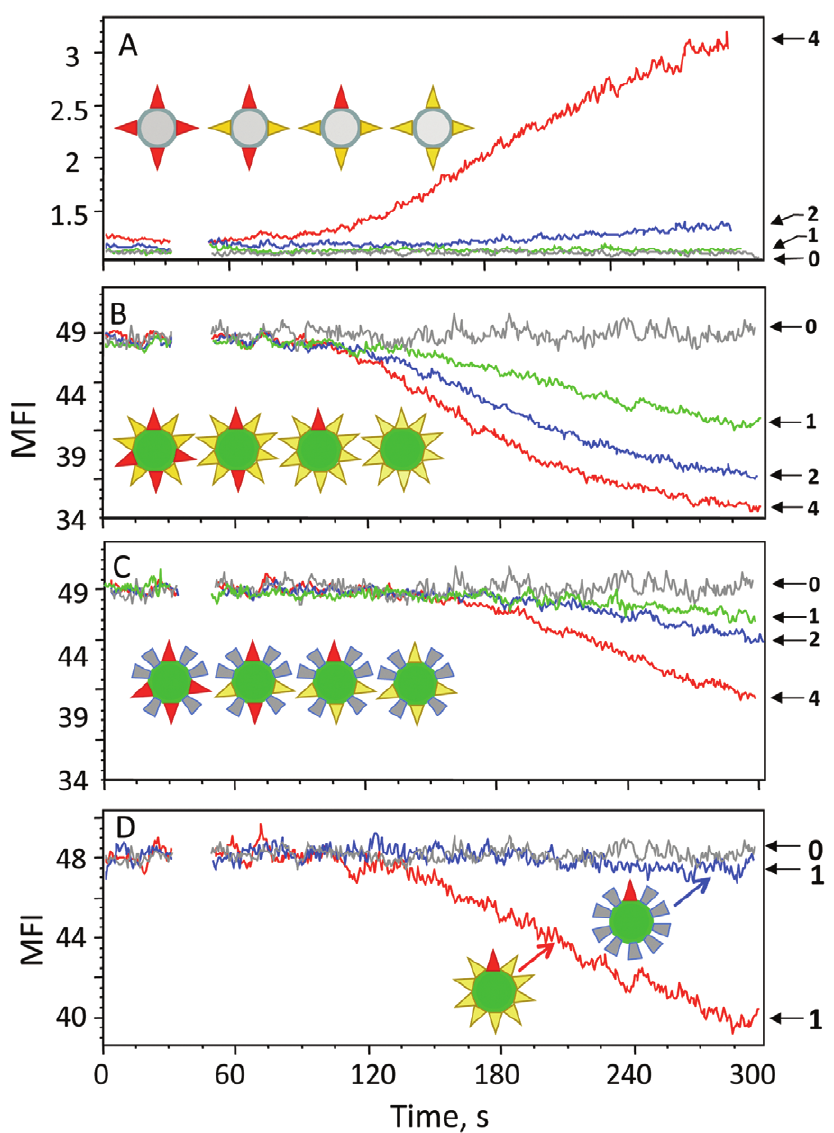
Figure 6. Kinetics of Ca 2 + flux in CTL stimulated with pMHC/QD or pMHC/Streptavidin containing cognate and noncognate or inactive pMHC ligands at various ratios. A. Time-dependent Ca 2 + accumulation in the cytoplasm of Fluo-3-labeled 68A62 CTL induced by Streptavidin-based oligomers presenting IV9-HLA-A2 (cognate, red) and Tax-HLA-A2 (noncognate, yellow) ligands at various ratios, i.e., 4:0, 2:2, 1:3, 0:4, respectively. Corresponding Ca 2 + flux traces are designated as 4 (4:0, red), 2 (2:2, blue), 1(1:3, green), 0(0:4, grey). B, C, D. Time-dependent Ca 2 + accumulation in the cytoplasm of Fura Red-labeled 68A62 CTL induced by QD-based oligomers presenting IV9-HLA-A2 (cognate, red), Tax-HLA-A2 (noncognate, yellow) or Tax-HLA-A2 mut (inactive, grey) ligands at various ratios. One series of pHLA-A2/QD conjugates being tested displayed 4, 2, 1 or 0 cognate (red) ligands per dot and 6, 8, 9 or 10 noncognate (yellow) ligands per dot keeping the total number of pHLA-A2 molecules per dot to be 10 (B). In another series of tested pHLA-A2/QD conjugates, the number of the cognate (red) ligands was the same, i.e., 4, 2, 1 or 0 per dot and the number of the noncognate (yellow) ligands per dot was 0, 2, 3, or 4, respectively, while the number of the inactive (grey) ligands and the total number of pHLA-A2 ligands per dot was kept 6 and 10, correspondingly (C). In the latter series (C), the density of noncognate Tax-HLA-A2 ligands on the conjugates was lower as compared to the conjugates of the former series (B). In the third series, QD presenting 1 cognate (red) along with either 9 noncognate (yellow) or with 9 inactive (grey) pMHC-I per dot were tested. QD presenting 10 inactive GL9-HLA-A2 mut proteins per dot were used as a negative control (D). Corresponding Ca 2 + flux profiles are designated as in A. potency was found to be stronger on the recognition of the weak agonist as opposed to the strong agonist pMHC-I ligands patches (70 nm in radius) on the cell surface, each containing 25– ( Fig. 4A,B ). 125 MHC molecules [19]. Similar density of pMHC-I within the MHC patches suggests that noncognate pMHC-I on the surface of From the size of QD(520) and the dimensions of pMHC protein live APC and target cells could also cooperate with cognate (including spacer) assembled on QD we have calculated the pMHC-I proteins and facilitate their recognition. In fact, this was density of pMHC molecules in the pMHC/QD conjugates to be < 7 6 10 3 molecule/ m m 2 . This is in a good agreement with the apparent from the comparison of CTL responses to target cells